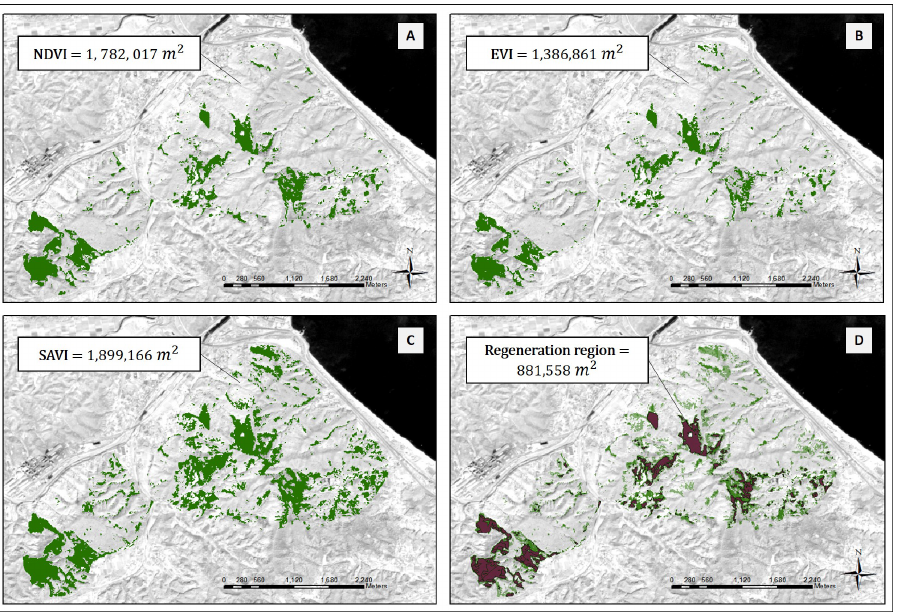
Figure 8. Match between the vegetation indices and NBR: ( A ) NDVI, ( B ) EVI, ( C ) SAVI, and ( D ) overlapped region of the vegetation indices and